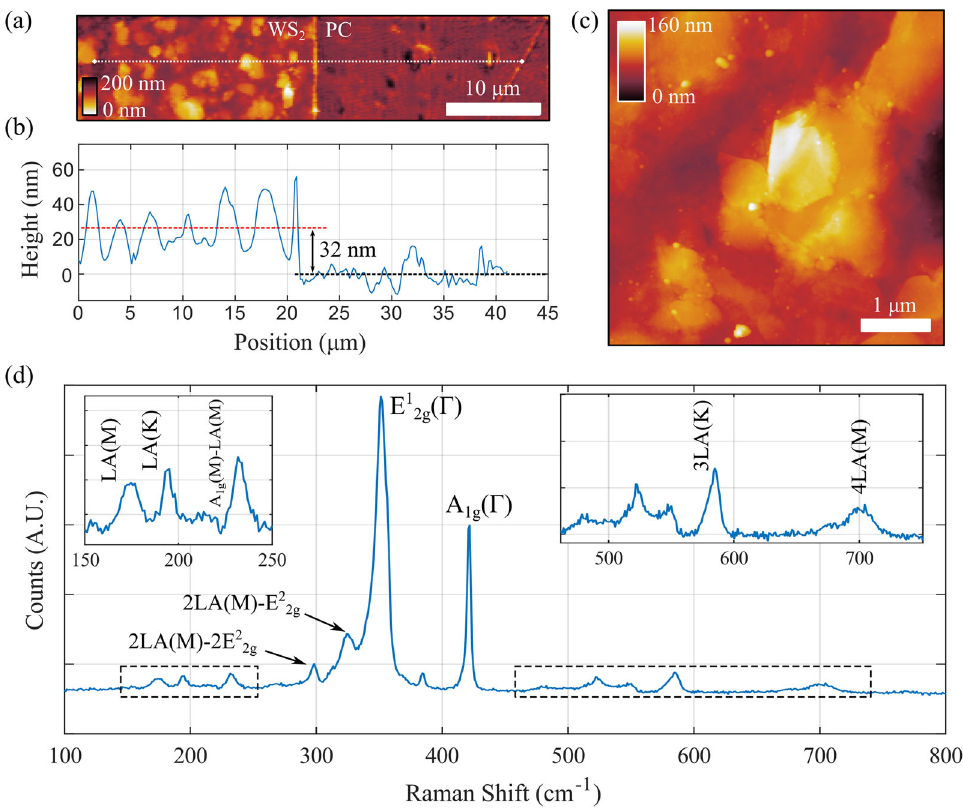
Fig. 2 Characterization of the as-deposited WS 2 fi lm. a Atomic force microscopy image of the step between the WS 2 fi lm and the bare polycarbonate substrate. b Line pro fi le measured along the line in a . An average thickness of ~32 nm is estimated from the pro fi le. c Higher magni fi cation atomic force microscopy image of the WS 2 fi lm where one can resolve some individual WS 2 fl akes, parallel to the surface, within the fi lm. d Raman spectrum of the WS 2 fi lm. The main peaks associated with WS 2 are labeled in the fi